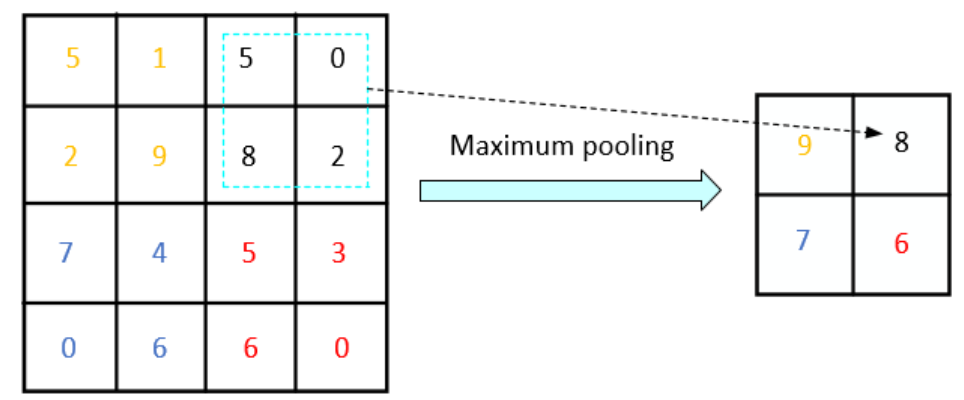
Figure 7. Maximum pooling principle.